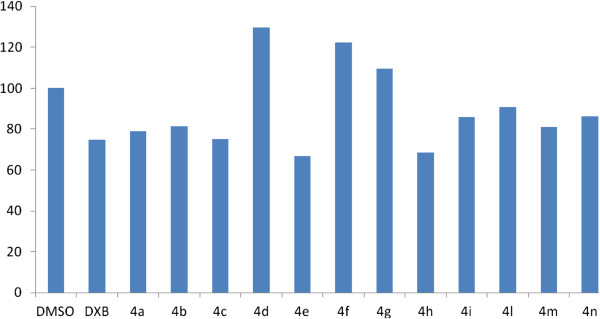
One-pot synthesis of 4-Aryl-4H-Naphthopyrans 4a-n.